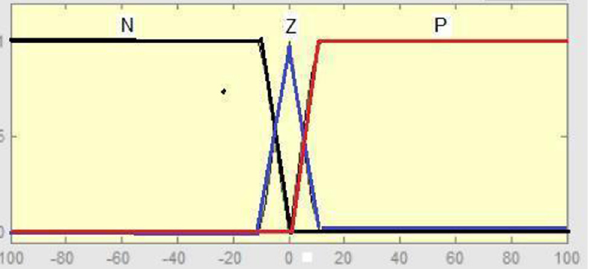
Fig. 12. Output membership function.